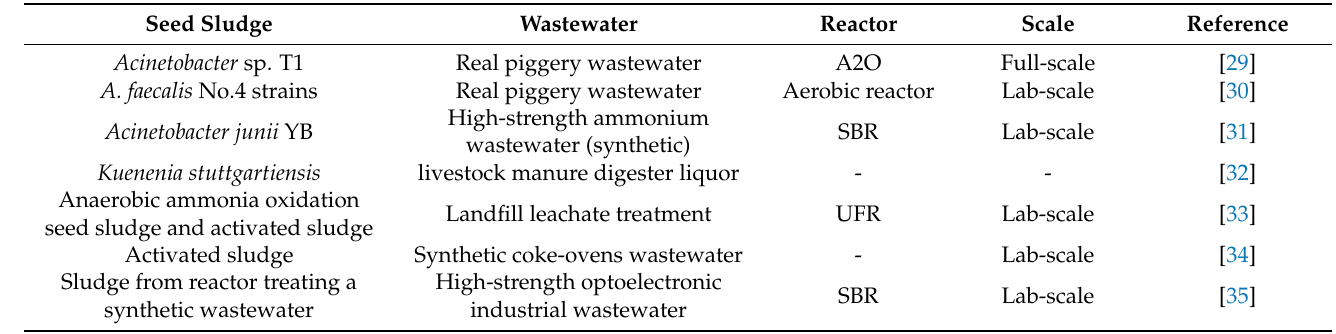
Table 3. Selected practical applications of simultaneous nitrification–denitrification and anaerobic ammonia oxidation processes.